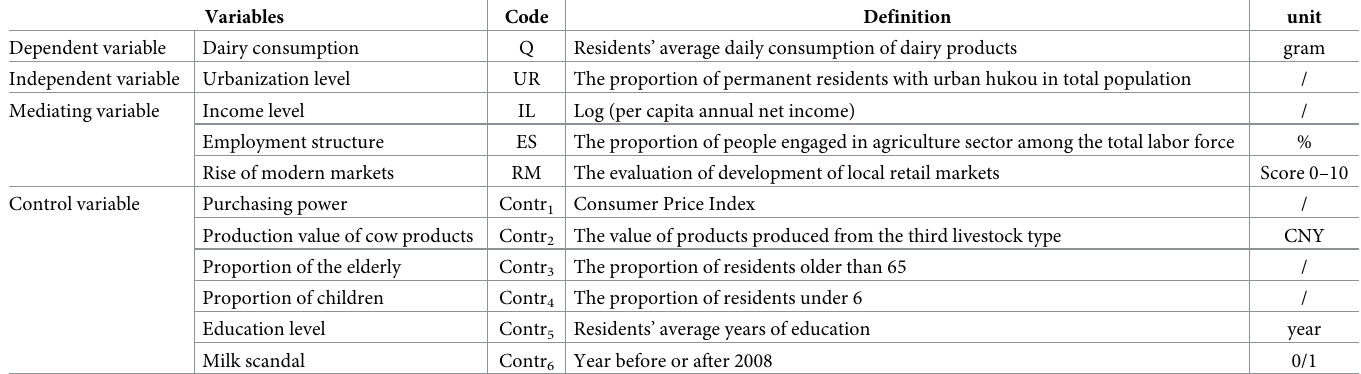
Table 1. Definition of